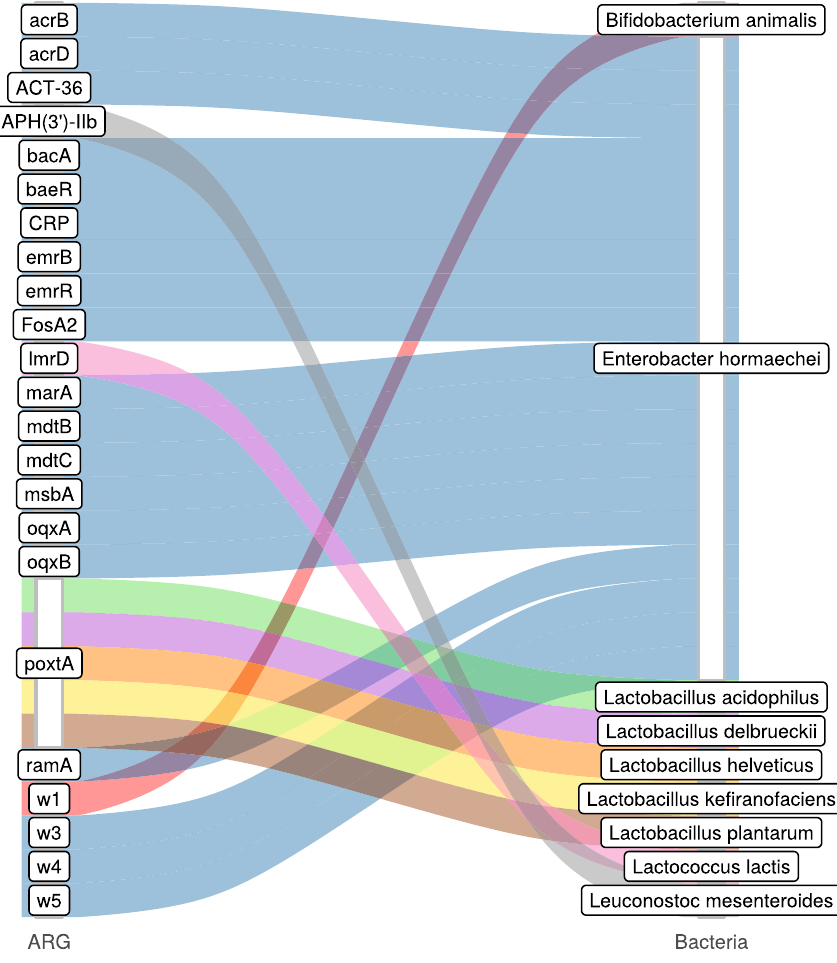
w3: Escherichia coli marR mutant conferring antibiotic resistance; w4: E. coli soxS with mutation conferring antibiotic resistance; w5: E. coli UhpT with mutation conferring resistance to